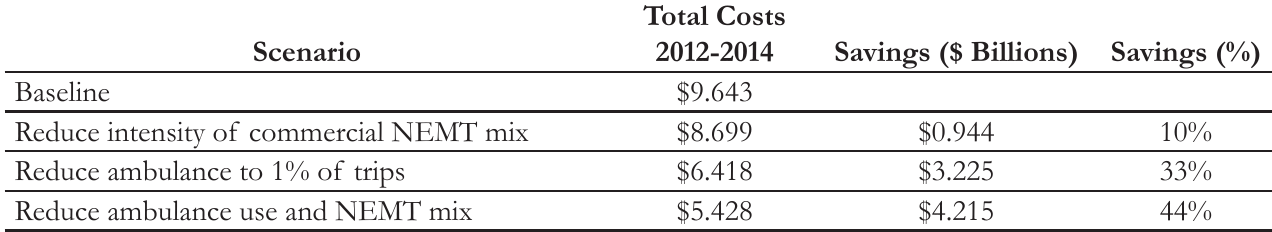
Table 8. Cost Savings Scenarios ($ Billions)